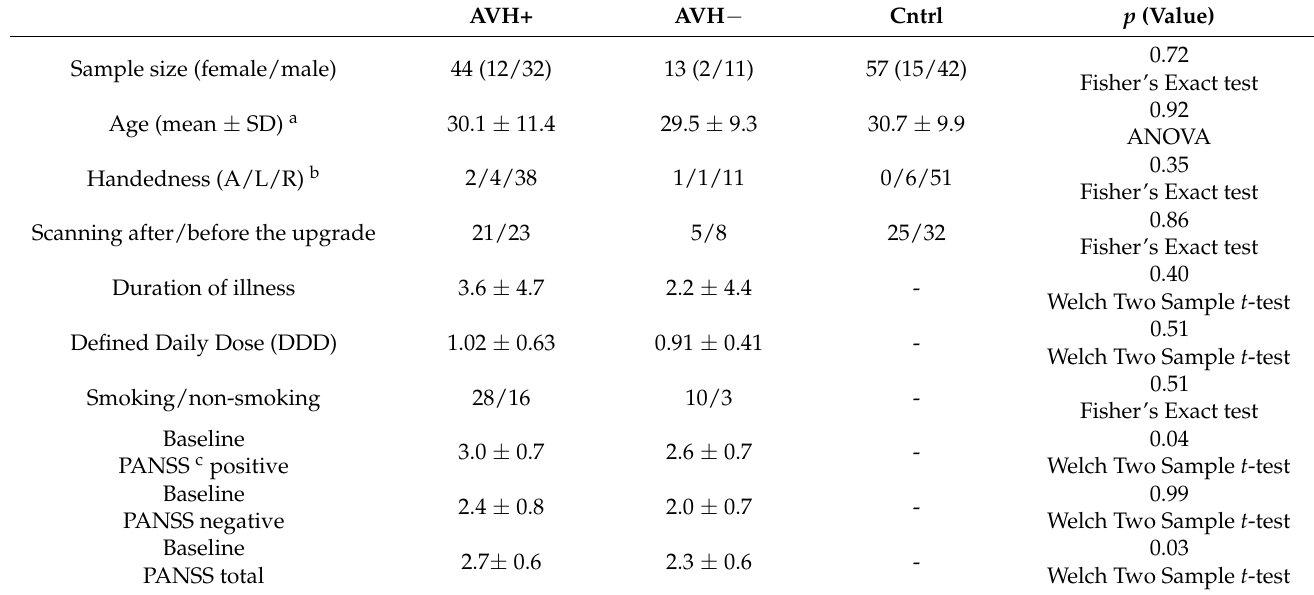
Table 1. Demographic and clinical information for the three groups (hallucinating patients (AVH+), non-hallucinating patients (AVH-), and healthy controls,